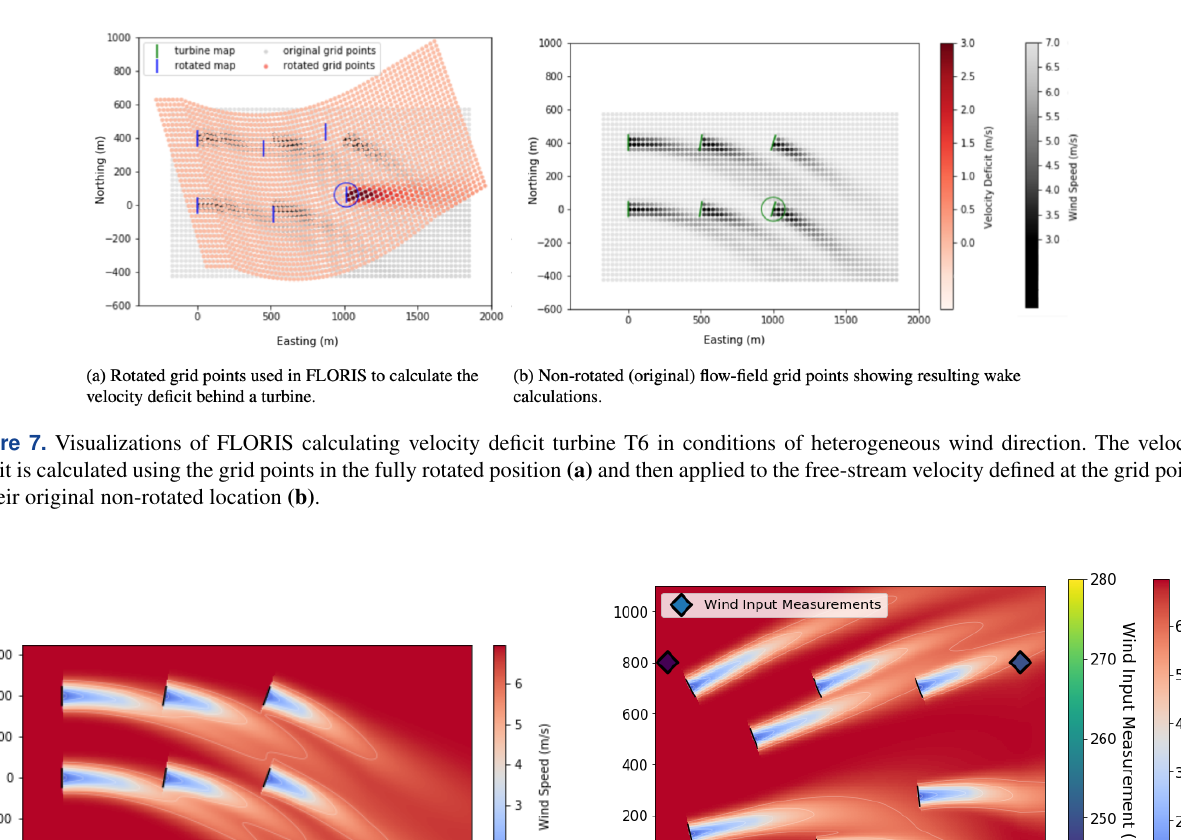
Figure 6. Depiction of the process performed in FLORIS to align the flow-field grid with the location and wind direction of turbine T6 (as defined in Fig. 5a).